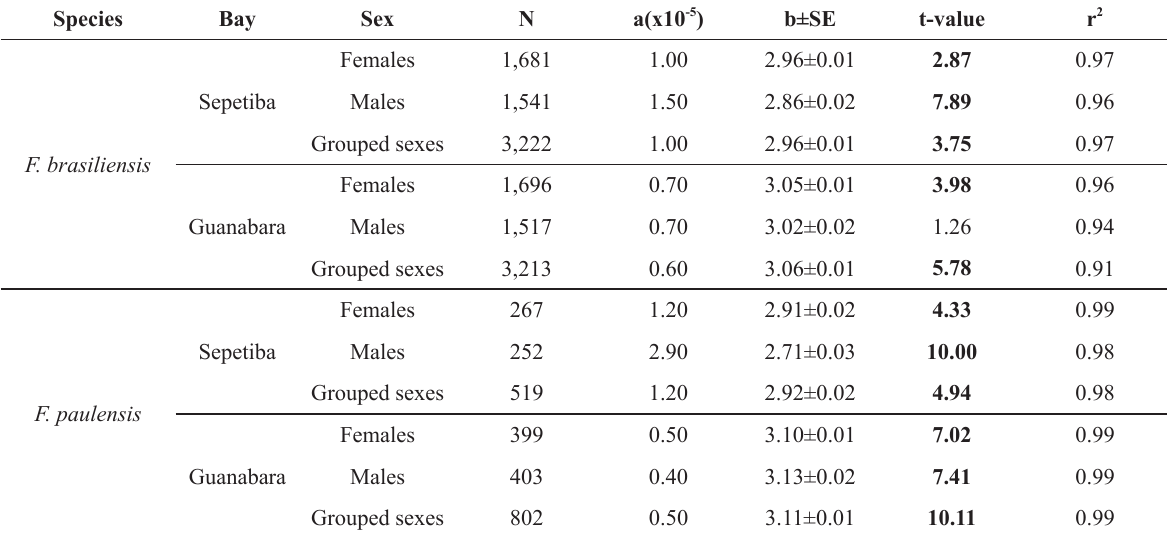
Parameter values of the equation W=a.TL b for each sex, species ( F. brasiliensis and F. paulensis ) and bay. Species